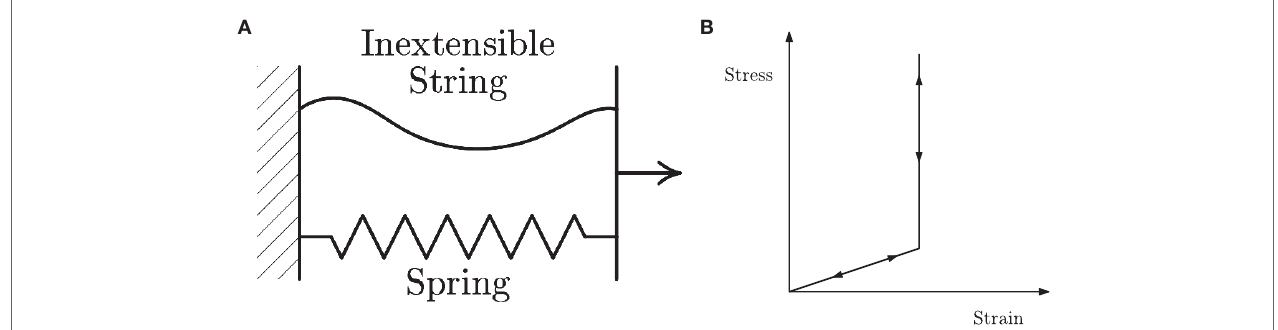
FigURe 1 | Mechanical analog and non-dissipative response . (A) A linear spring and an inextensible rope in parallel. The spring need not be a linear spring. (B) Non-dissipative response wherein the stress cannot be expressed explicitly as a function.